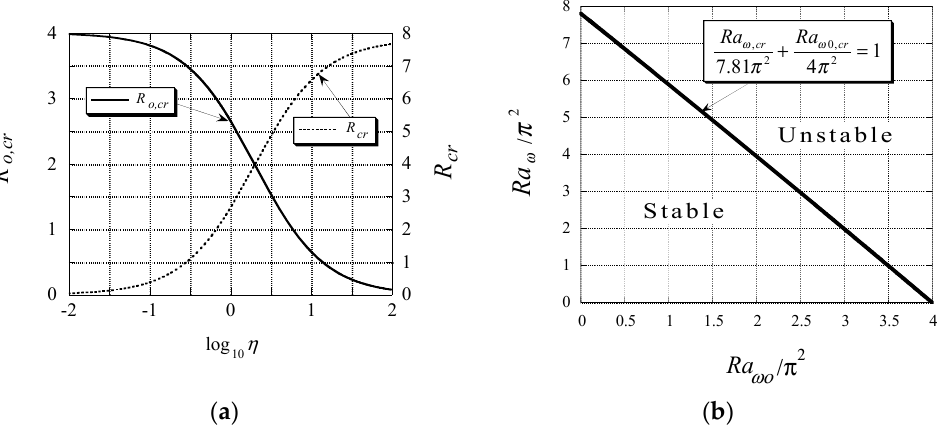
Figure 5. ( a ) The variation of the critical values of the centrifugal Rayleigh numbers as a function of η ; ( b ) The stability map on the Ra ω − Ra ω o plane showing the division of the plane. (Reprinted from [40], with permission from Springer.)